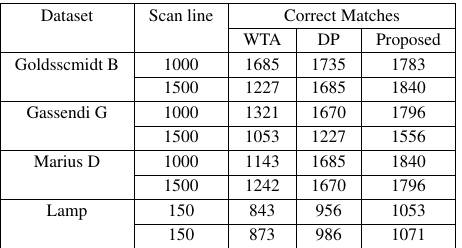
Table 4: Correct matches